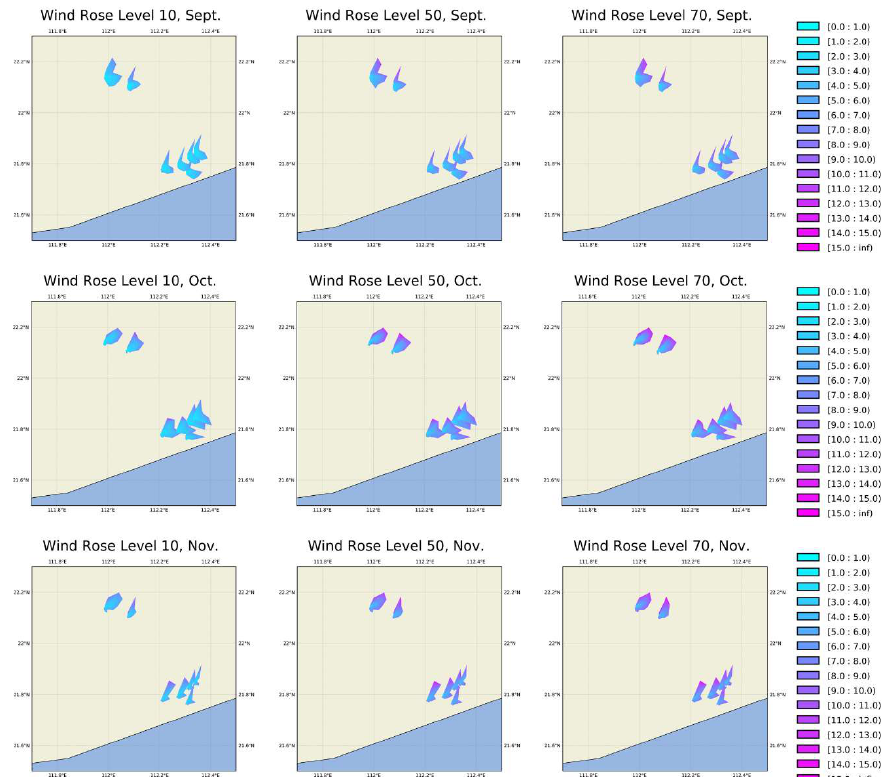
Figure A3. Wind rose of Test 2 results in the seven tower positions in autumn (Sept., Oct., and Nov.).